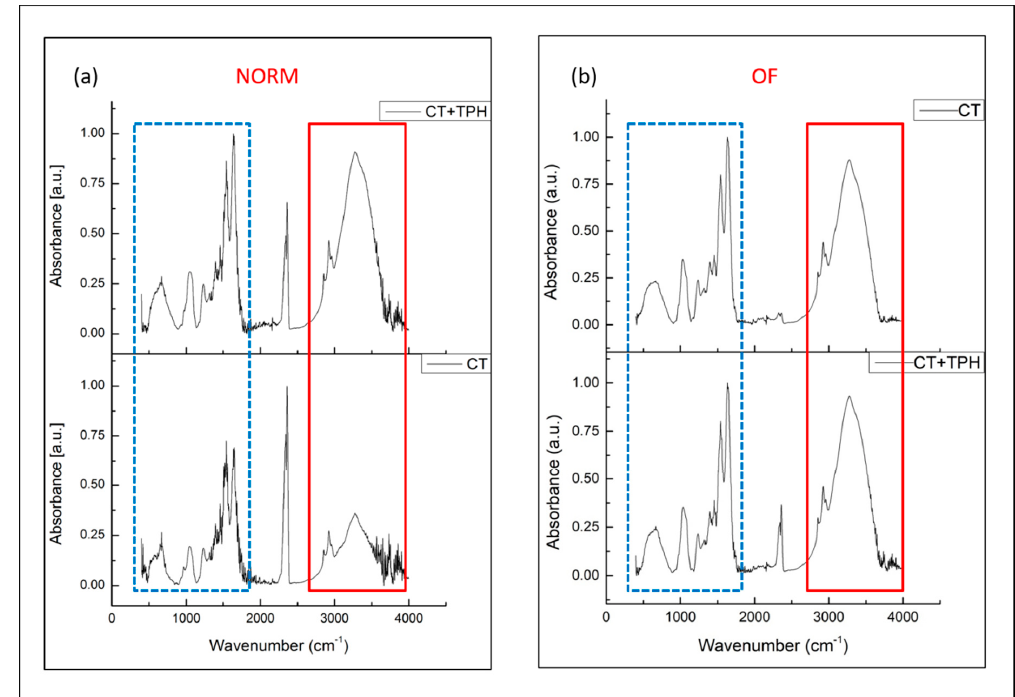
Figure 2. FITR spectra of the samples CT and CT + TPH cultured with ( a ) the normal medium, ( b ) the medium with the osteoinductive factors. Two zones of interest are highlighted with the blue rectangle between 400 and 1100 cm − 1 and by the red rectangle between 2700 cm − 1 and 3600 cm − 1 . Int. J. Mol. Sci. 2018 , 19 , x Deposition of hydroxyapatite was also investigated by means of RAMAN spectroscopy and the results are reported in Figure 3.